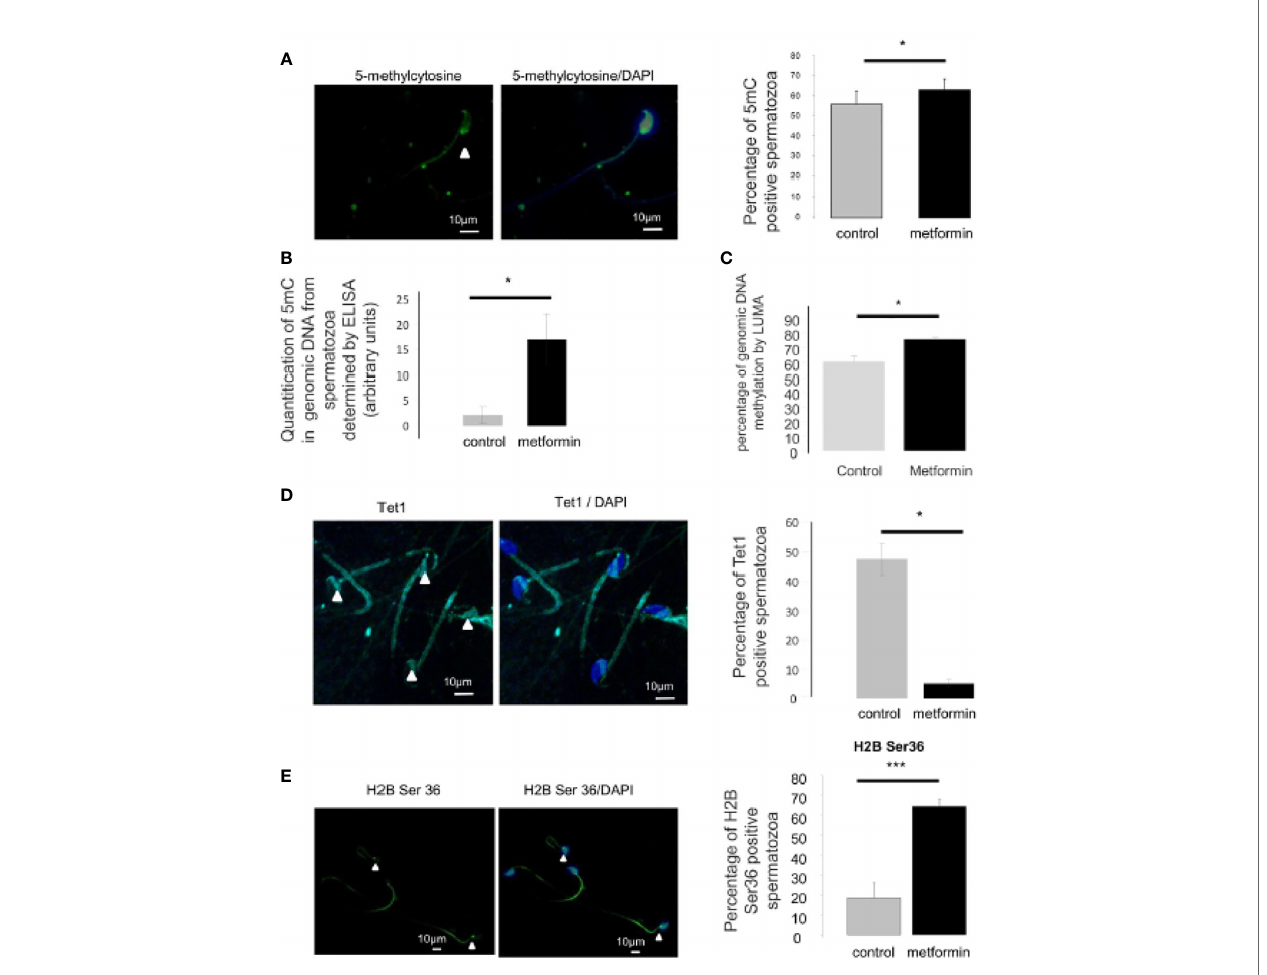
FIGURE 10 | Analysis of epigenetic mark in spermatozoa. (A) Immunocytochemistry (green) against 5 methyl-cytosine in spermatozoa. Nucleus was stained with DAPI (blue). Quanti fi cation is shown on the right side of the micrographs (n=4 mice, at least 100 spermatozoa per individual were counted). Scale bar = 10 µm. (B) Percentage of 5mC in genomic DNA from spermatozoa was measured by ELISA assay and (C) percentage of genomic DNA methylation in epididymis cauda was analysed by LUMA. (D) Immunocytochemistry (green) against TET1 in spermatozoa. Nucleus was stained with DAPI (blue). Quanti fi cation is shown on the right side of the micrographs (n=4, at least 100 spermatozoa per individual were counted). Scale bar = 10 µm. (E) Immunocytochemistry (green) against phospho-Ser36- H2B in spermatozoa. Nucleus was stained with DAPI (blue). IgG was used as negative control. Quanti fi cation is shown on the right side of the micrographs (n=3-4, at least 100 spermatozoa per individual were counted). Scale bar = 10 µm. Values are expressed as mean ± SEM. *p < 0.05; ***p <